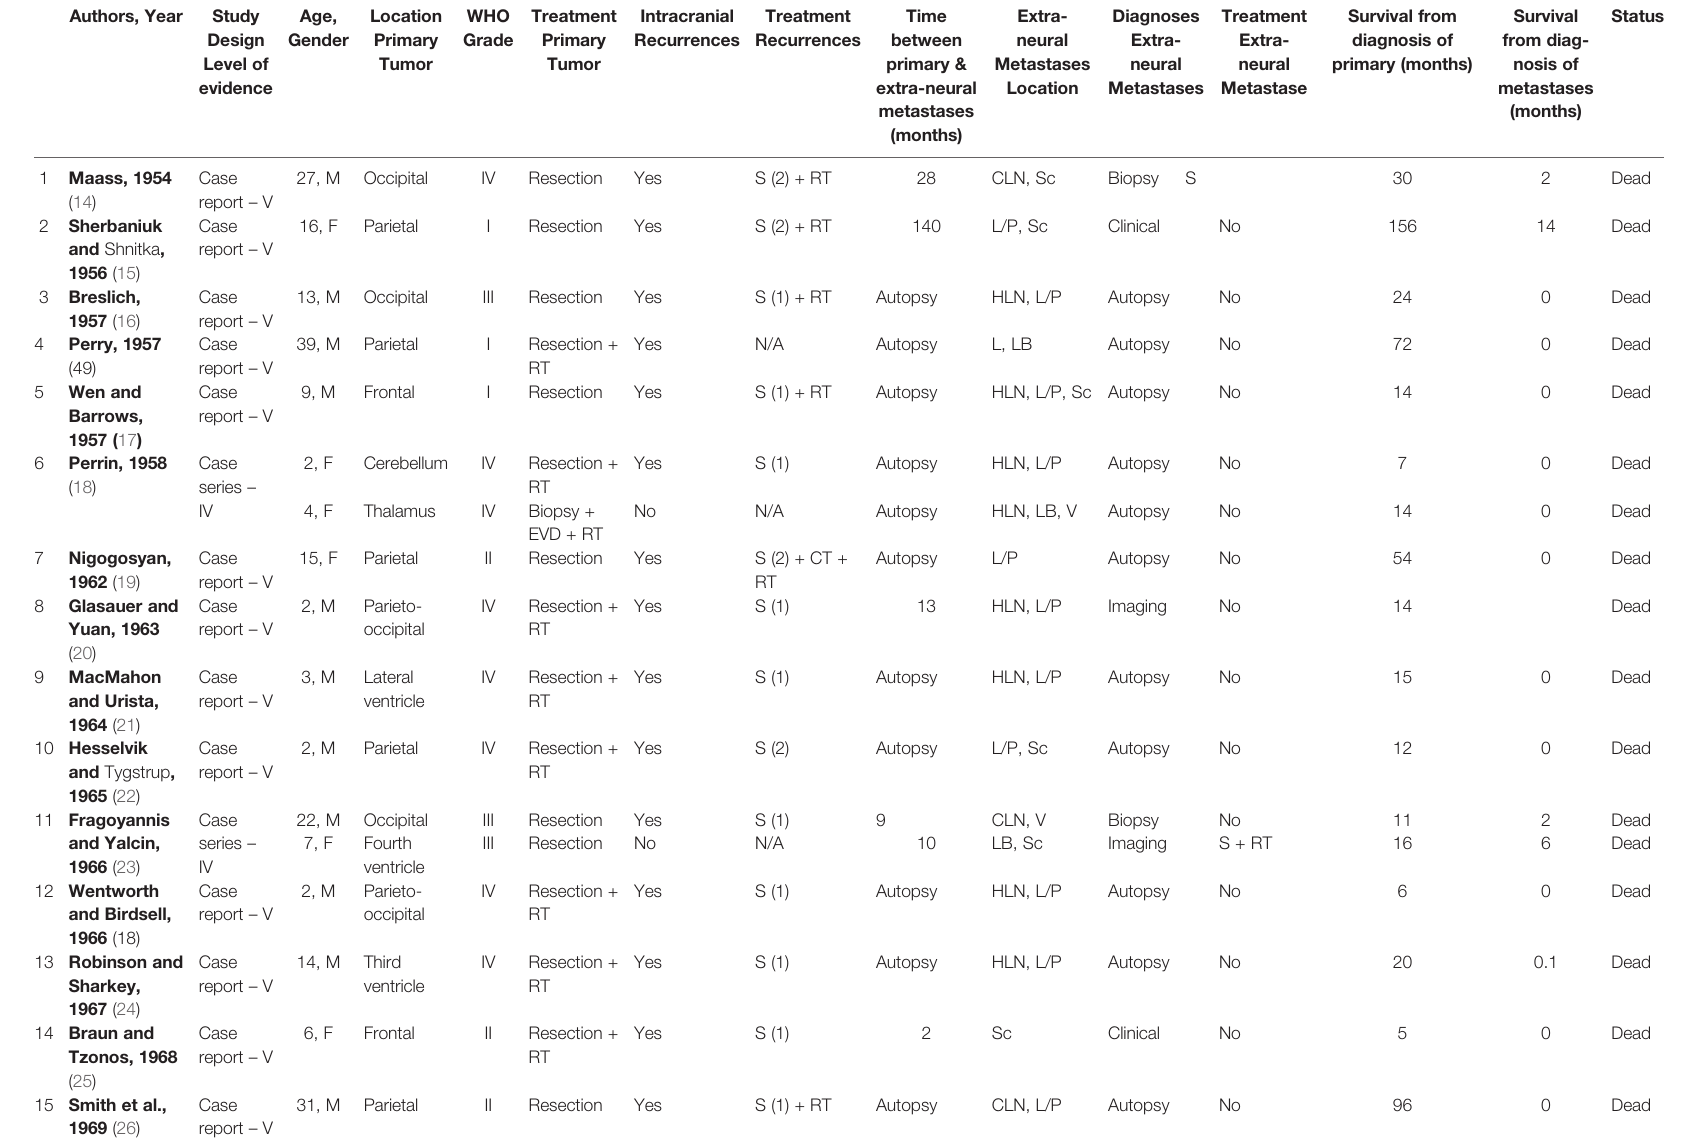
TABLE 1 | Overview of all included